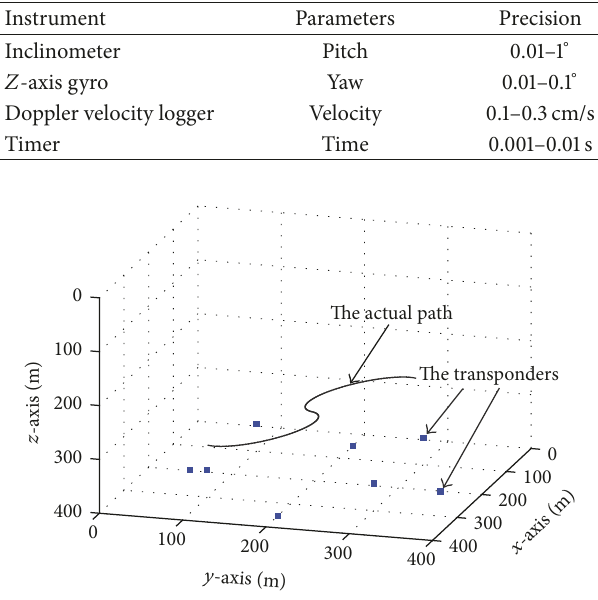
Figure 3: The simulation environment of the localization